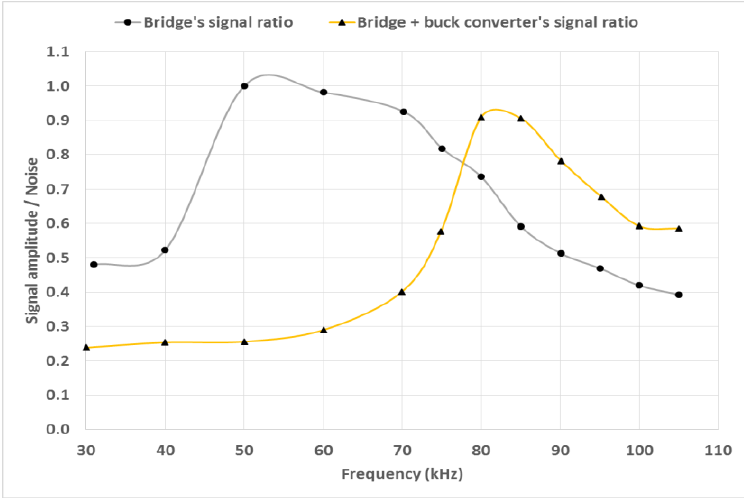
Figure 20. Signal/noise ratio for both FB and FB+buck converter vs pulse frequency.